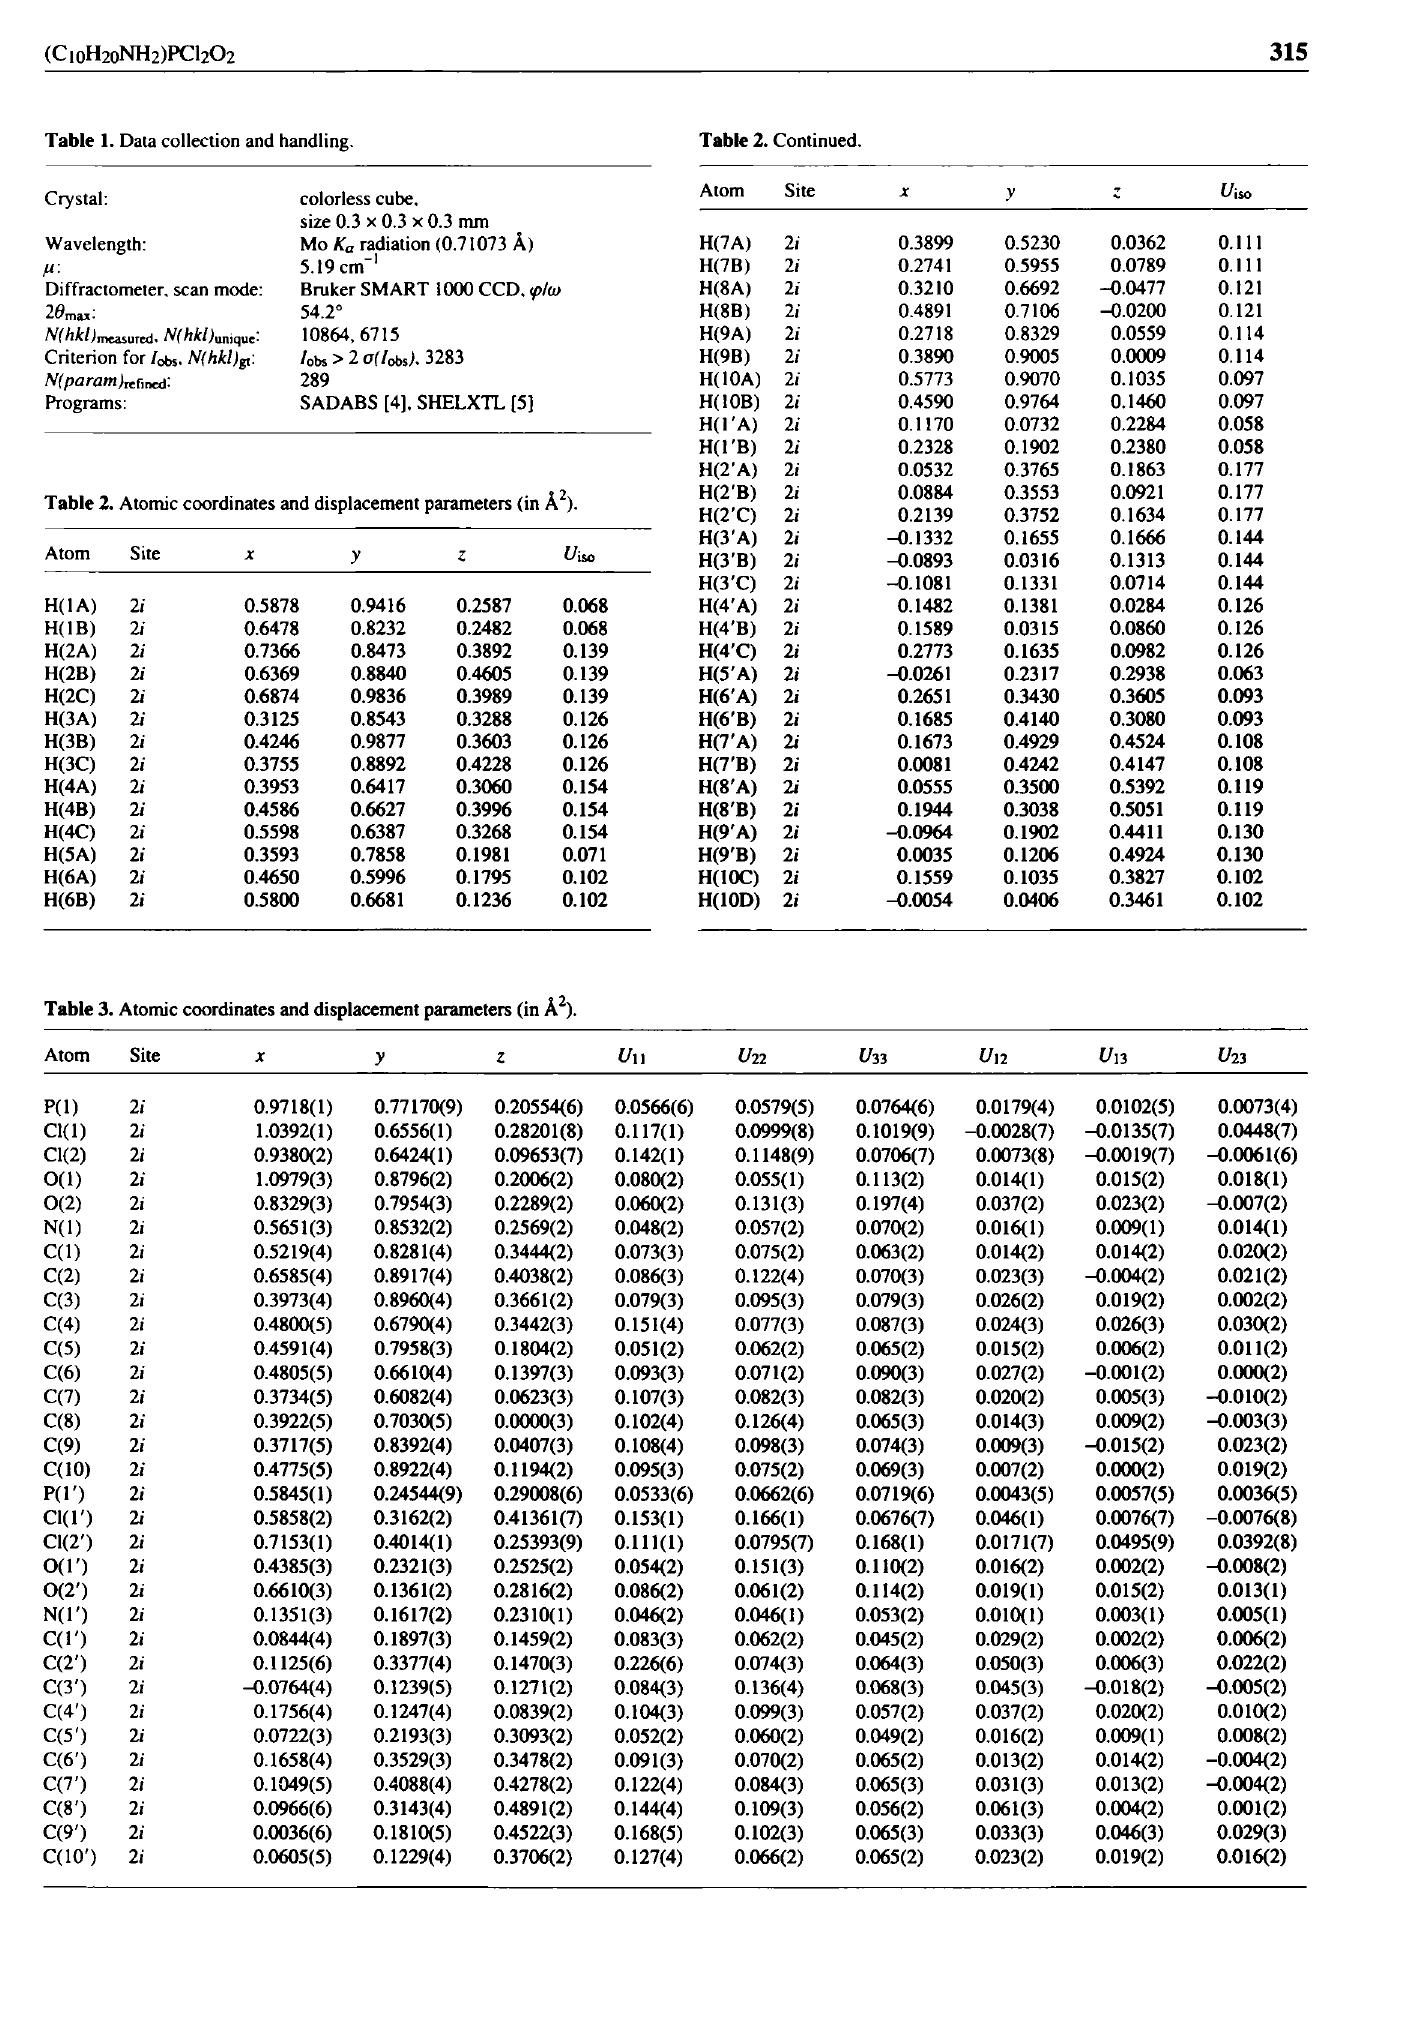
Table 2. Atomic coordinates and displacement parameters (in Â 2 ).